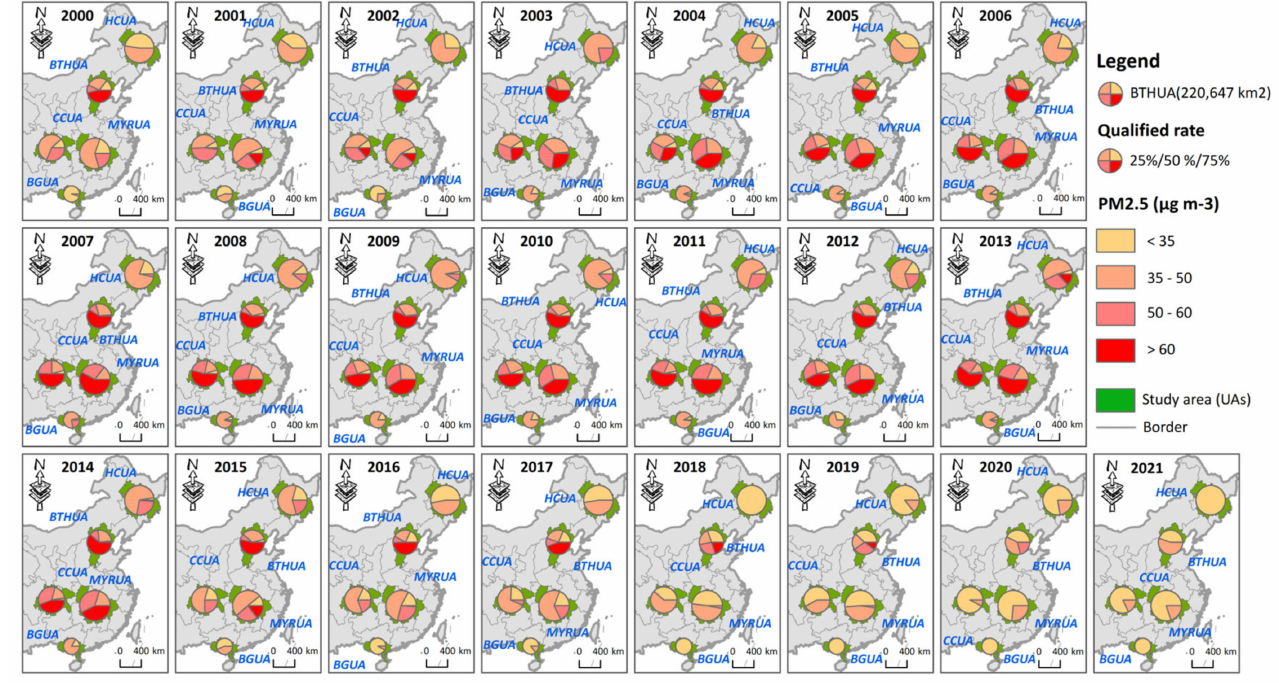
Figure 7. Qualified rate of PM 2.5 air quality in the five UAs over the period